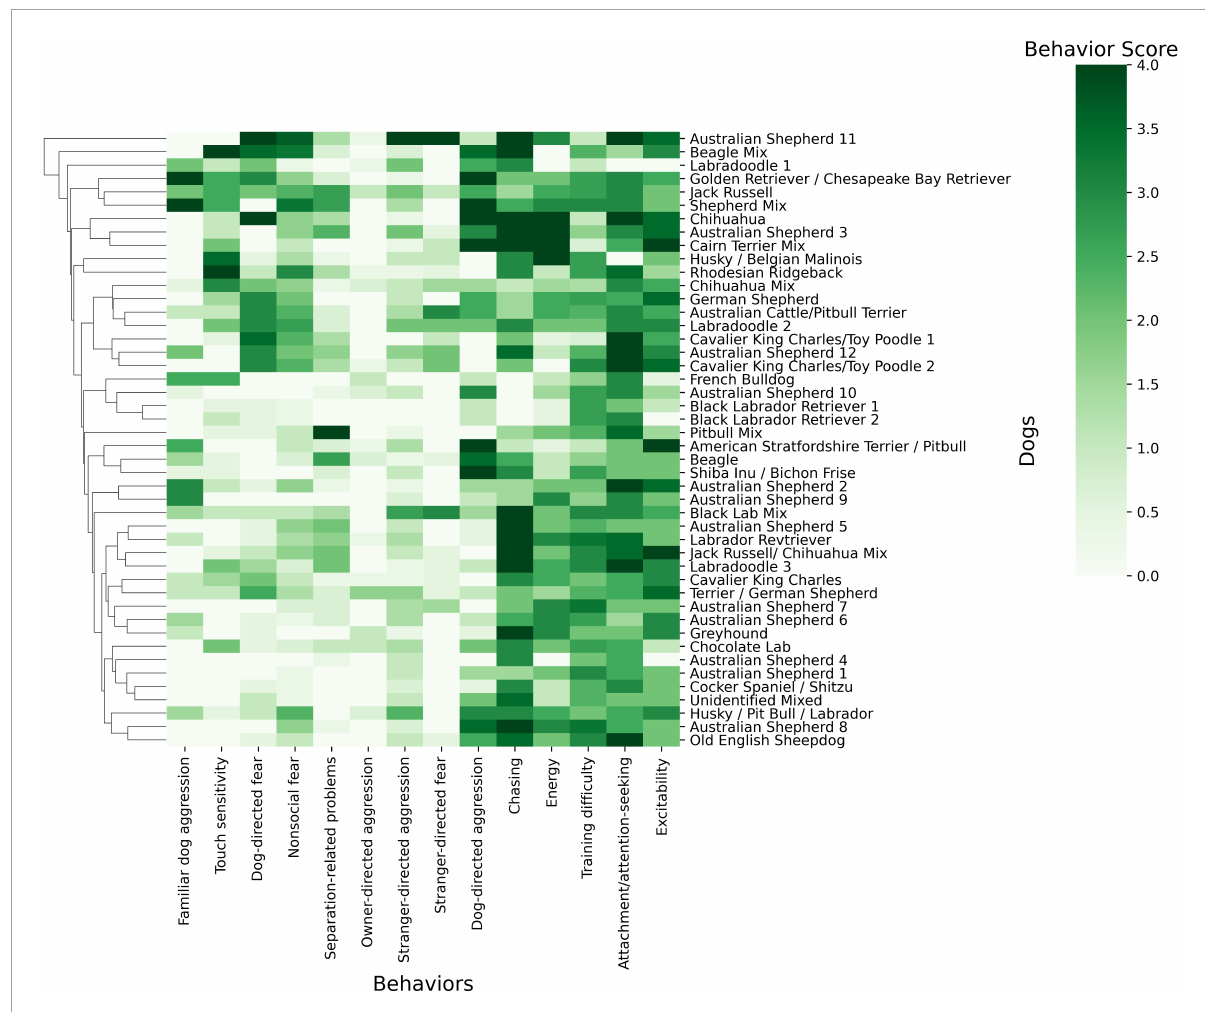
FIGURE1 Heat map of the dog phenotype data and breed using Python Seaborn Clustermap (Waskom, 2021). The map depicts dog’s breeds and their scores from 0 to 4 in the 14 behavioral phenotypes. White colors indicate a score of 0 for a behavioral phenotype while darkening shades of green indicate a behavioral score close to 4. Related breeds and traits are clustered close to one another on nodes of the hierarchical trees. These nodes are determined by hierarchical